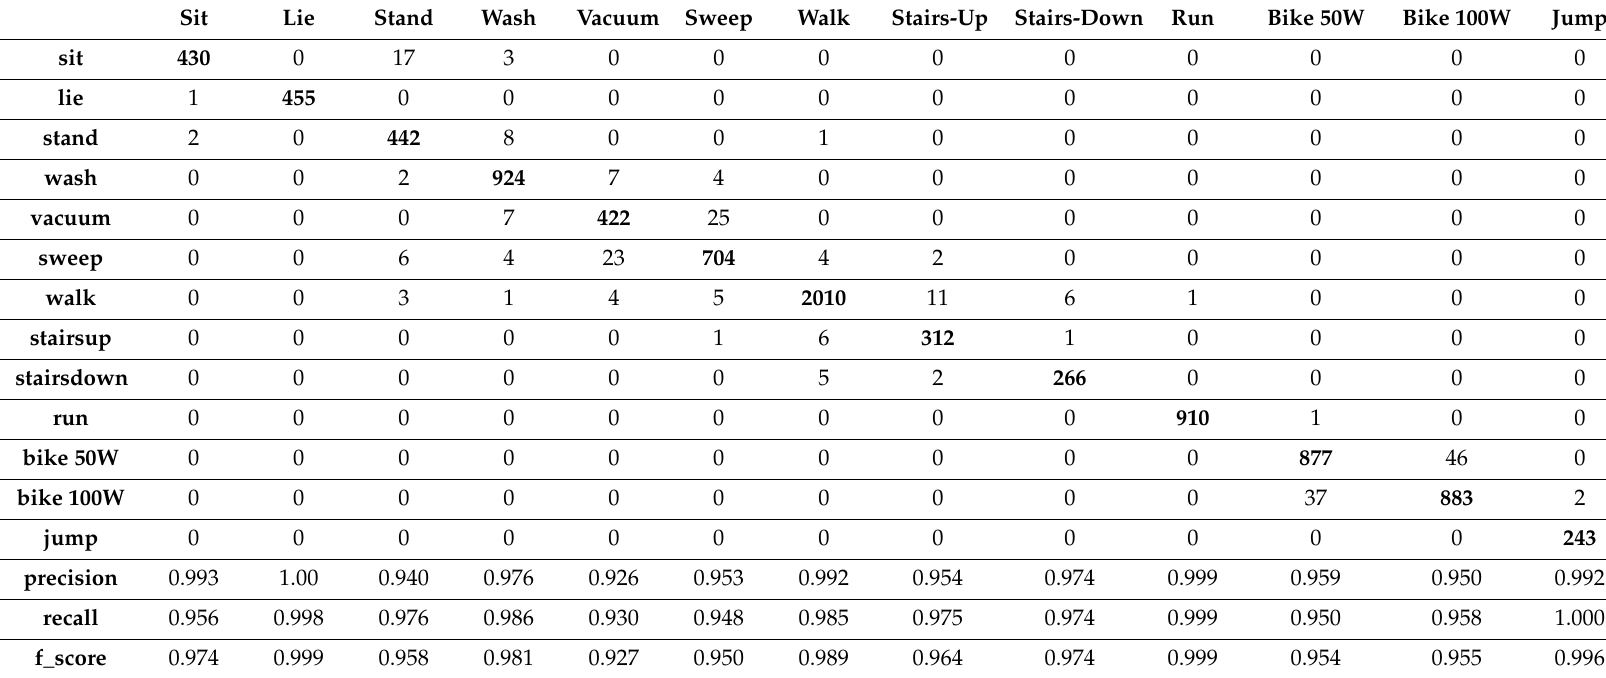
Table 3. Aggregated confusion matrix for all leave-one-subject-out rounds (logistic regression). Class-specific precision, recall and f-score ( β = 1) are reported for each class of the DaLiAc dataset. Values in bold (diagonal) represent correct